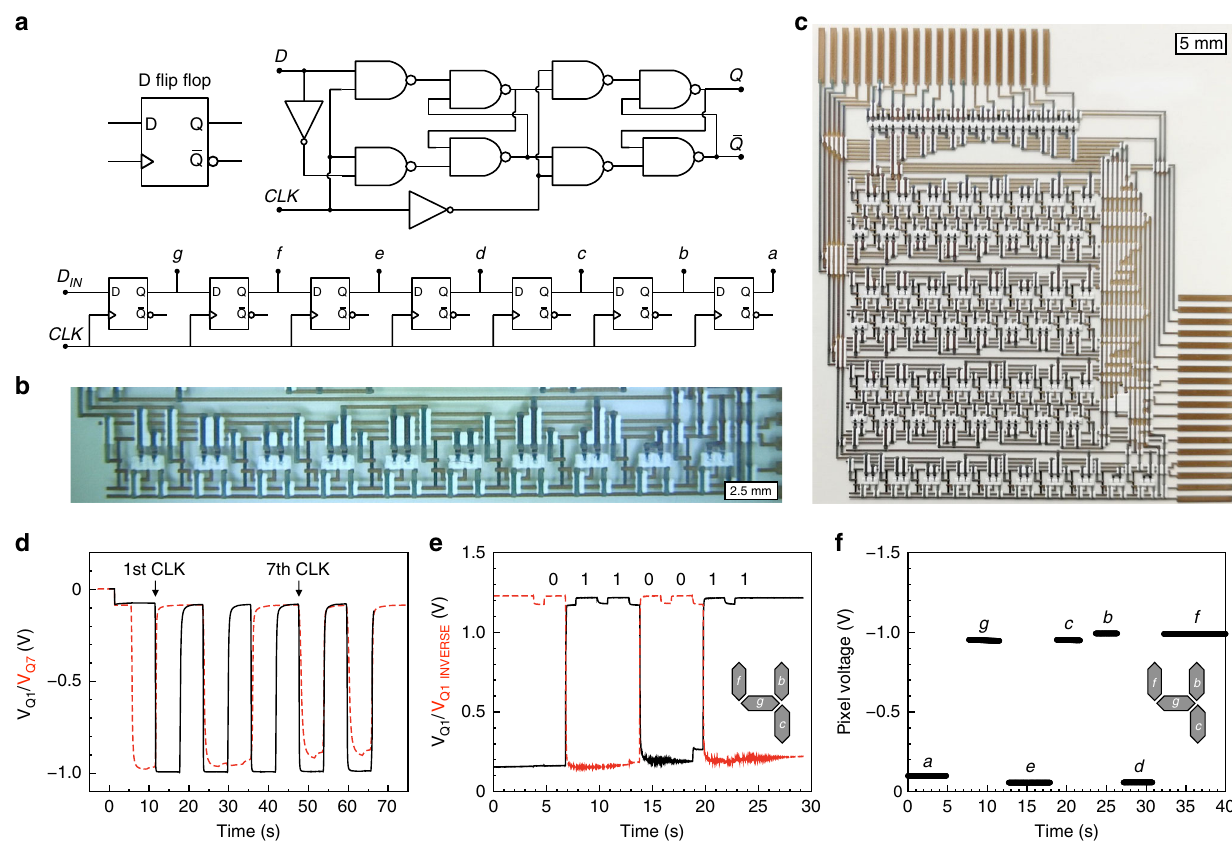
Fig. 5 Seven-bit shift register based on organic electrochemical transistors. a Schematic and symbol of a Master-Slave D fl ip- fl op implemented via inverters and two-input NAND gates, and a seven-bit shift register cascading seven stages of D fl ip- fl ops. b , c Photographs of the all-printed D fl ip- fl op ( b , scale bar: 2.5 mm) and the seven-bit shift register ( c , scale bar: 5 mm). d Voltage outputs from the shift register at display segments g and a, corresponding to the